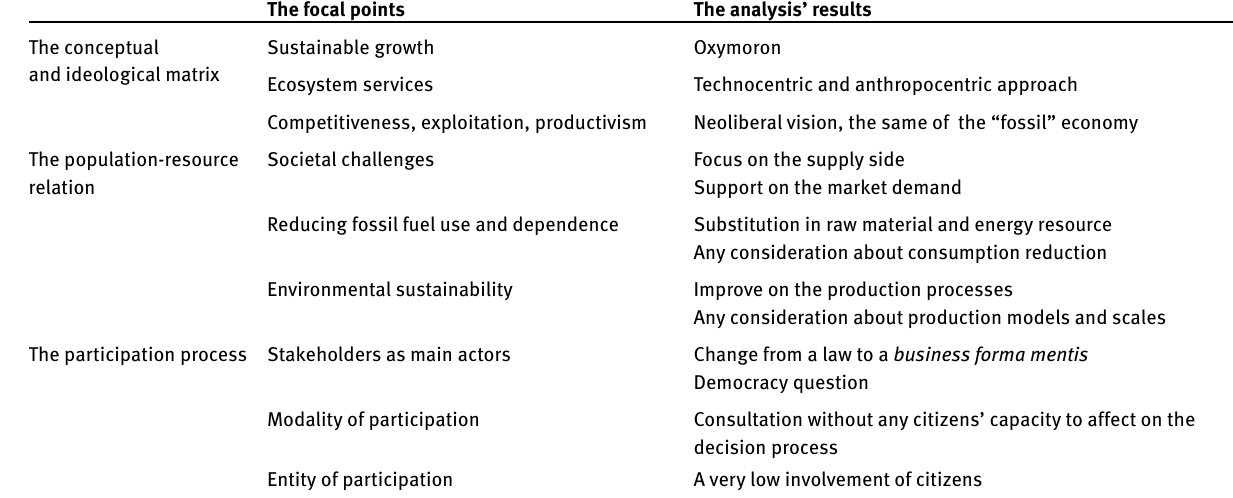
Table 1: “Innovating for Sustainable Growth: a Bioeconomy for Europe”: the main results of analysis The focal